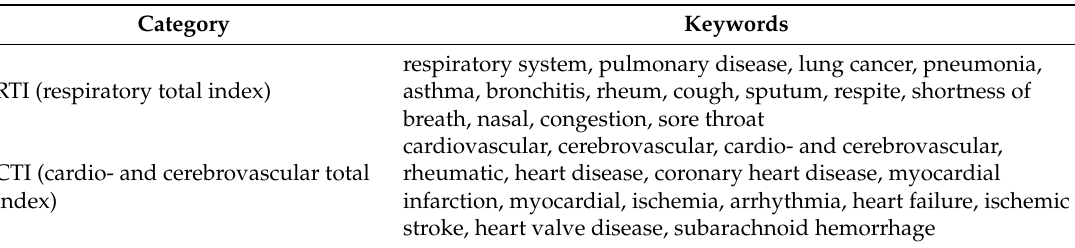
Table 2. The selected keywords for the Baidu